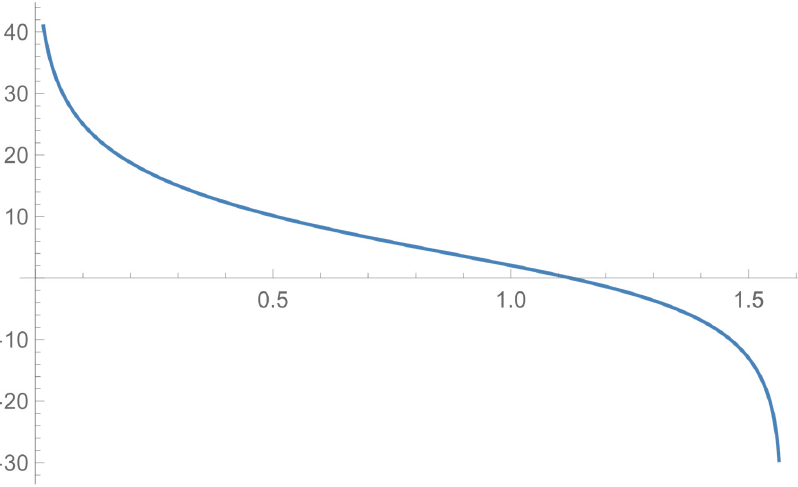
Figure 4. (cid:1846) (cid:2868) in the interval (cid:2010) ∈ [0,(cid:2024)/2]. Figure 4. T 0 in the interval β